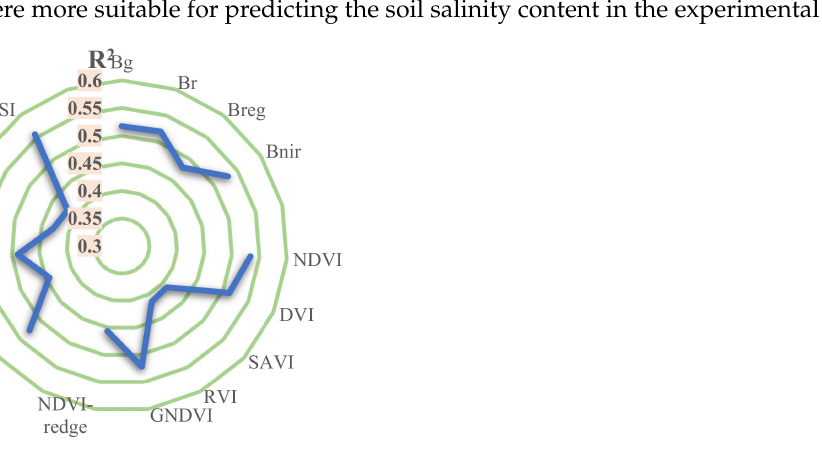
Figure 5. Statistics of reflectivity and modeling accuracy for different bands and spectral parameters.